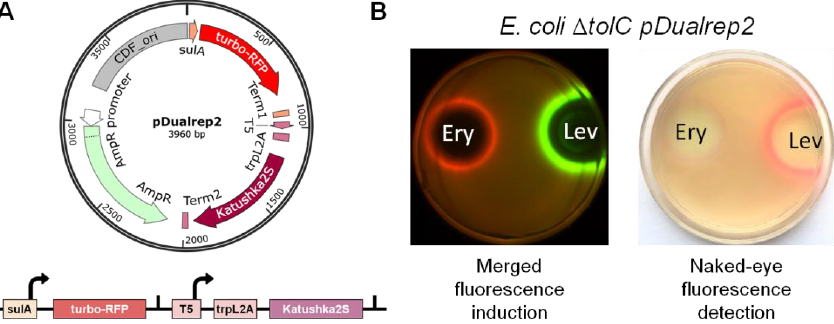
Figure 1. Double reporter system pDualrep2. ( A ) pDualrep2 plasmid map and the reporter scheme. CDF_ori, CloDF13-derived CDF replicon; sulA, promoter of the sulA gene; T5, bacteriophage T5 promoter; trpL2A, modified trpL leader open reading frame carrying W10A and W11A substitutions. Transcription start sites are shown by arrows. Transcription terminators are shown by vertical dashes. ( B ) Comparison of fluorescence signals using an imaging system (left) and with the naked eye (right). An agar plate was coated with the E. coli Δ tolC strain transformed with the pDualrep2 plasmid and spotted with erythromycin (Ery) and levofloxacin (Lev). The plate was scanned in Cy3 (for TurboRFP) and Cy5 (for Katushka2S) channels, shown as green and red pseudocolors,